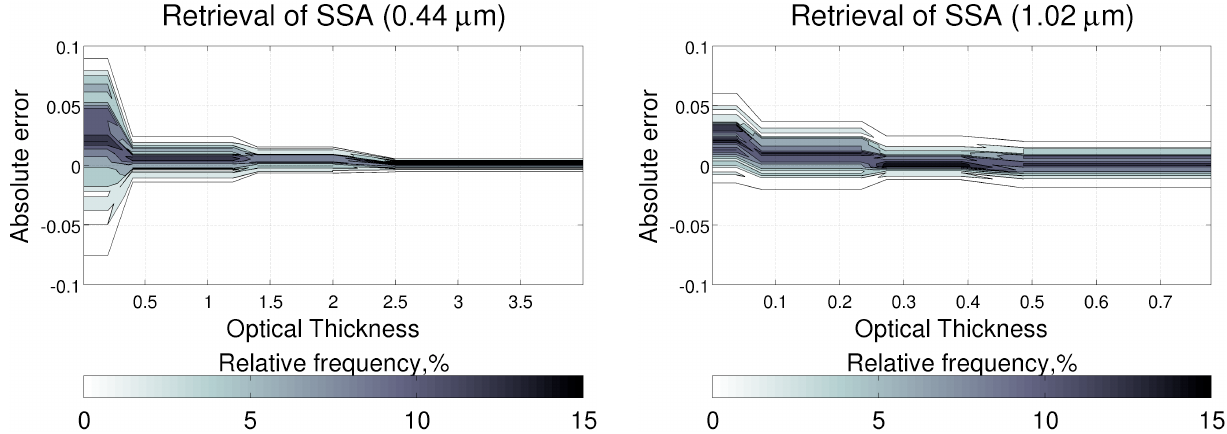
3 Fig. 17. Statistics of the retrieval errors of biomass burning single scattering albedo over Mongu in the series of the numerical tests for